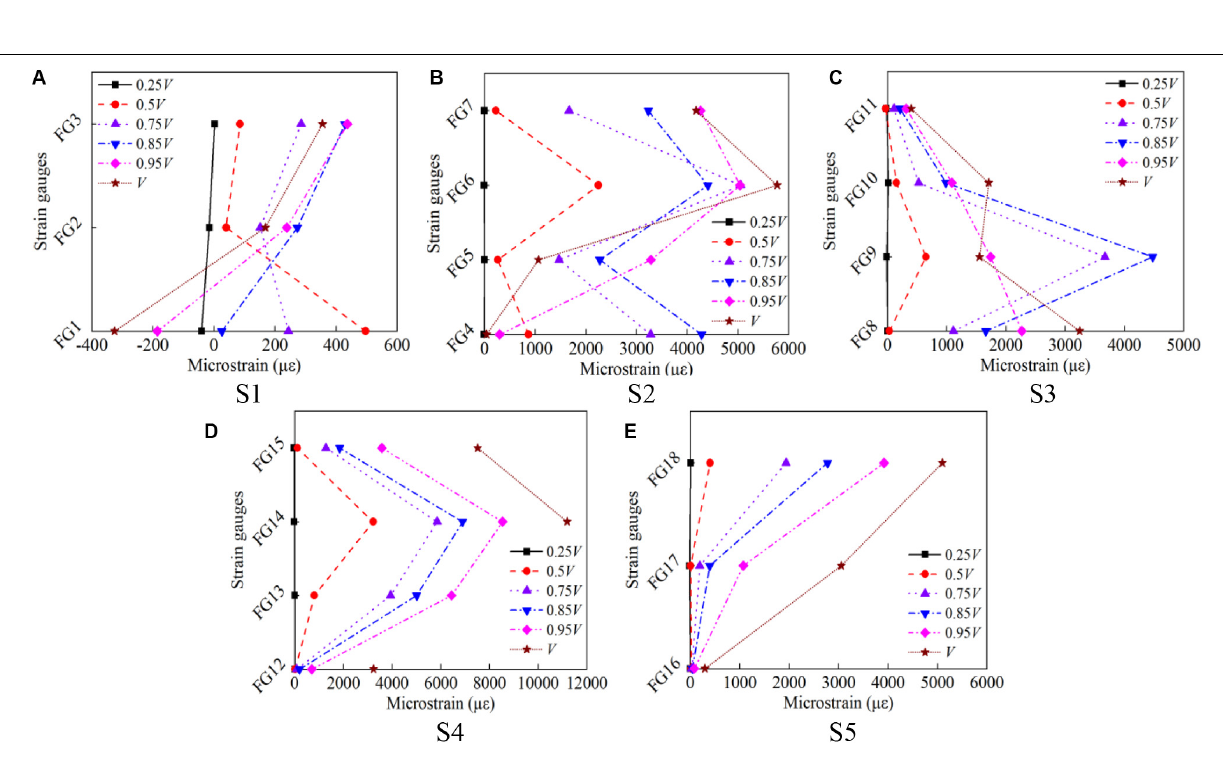
Frontiers in Materials |